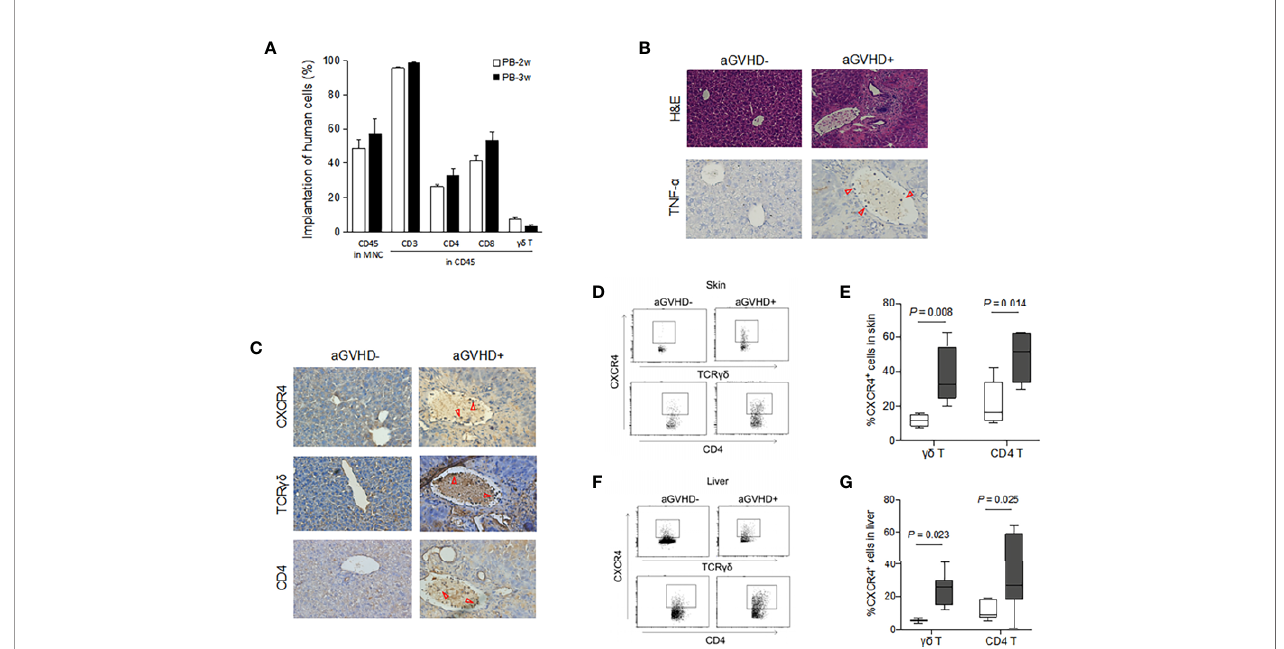
FIGURE 6 | Migrations of human gd T cells and CD4 T cells expressing CXCR4 in mice with or without aGVHD. Immunode fi cient mice were transplanted with human PBMCs as described. The proportion of human CD45-positive cells was detected in mouse peripheral blood by fl ow cytometry at 2 and 3 weeks after injection (A) . Histopathological examination was performed on biopsy specimens of liver obtained from transplanted mice. Histopathological feature and expression of TNF- a in liver were detected by hematoxylin and eosin (H&E, ×100) staining and immunohistochemistry analyses, ×200 (B) . Three adjacent sections of liver biopsies were stained with antibodies against CXCR4, TCR gd and CD4, ×200 (C) . CXCR4-expressing gd T and CD4 T cells were detected by fl ow cytometry in the skin (D, E) and liver (F, G) of mice with or without aGVHD. n = 4, P values are shown on the